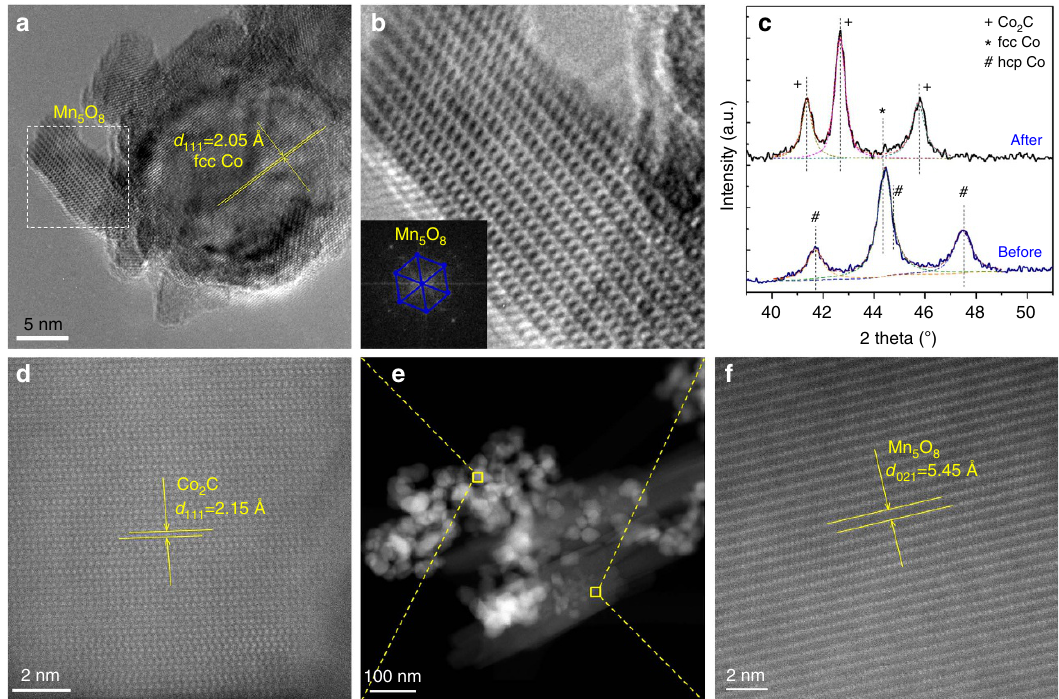
Figure 4 | Structural characterizations of Co 4 Mn 1 K 0.1 catalysts. ( a ) HRTEM image of Co 4 Mn 1 K 0.1 catalyst before reaction; ( b ) enlarged HRTEM image and (inset) its Fourier transform of the selected region of a ; ( c ) XRD patterns of Co 4 Mn 1 K 0.1 catalyst: both before and after CO hydrogenation; ( d – f ) HAADF-STEM images of Co 4 Mn 1 K 0.1 catalyst after CO